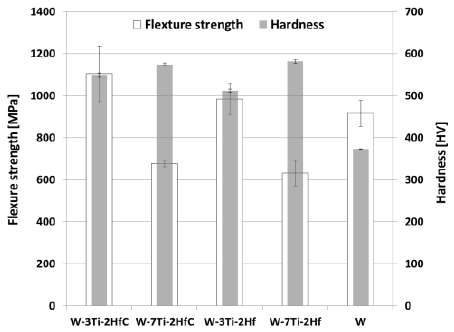
Figure 7. Flexural strength and hardness of the prepared samples in comparison with properties of pure